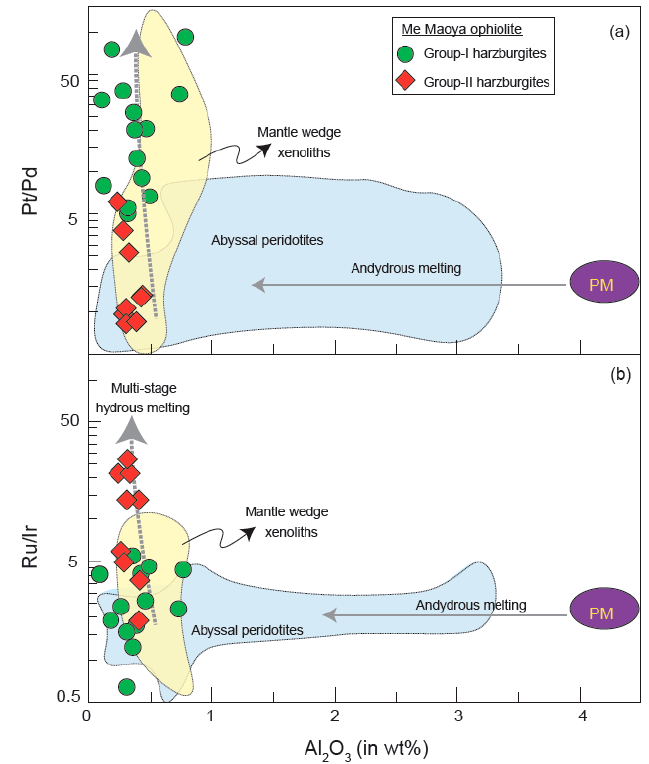
Figure 7. Pt/Pd ( a ) and Ru/Ir ( b ) versus bulk Al 2 O 3 contents in the Me Maoya harzburgites. Fields of Figure 7. Pt / Pd ( a ) and Ru / Ir ( b ) versus bulk Al 2 O 3 contents in the Me Maoya harzburgites. Fields of mantle wedge xenoliths [12,13] and abyssal peridotites [32,37,43–45] are also shown. mantle wedge xenoliths [12,13] and abyssal peridotites [32,37,43–45] are also